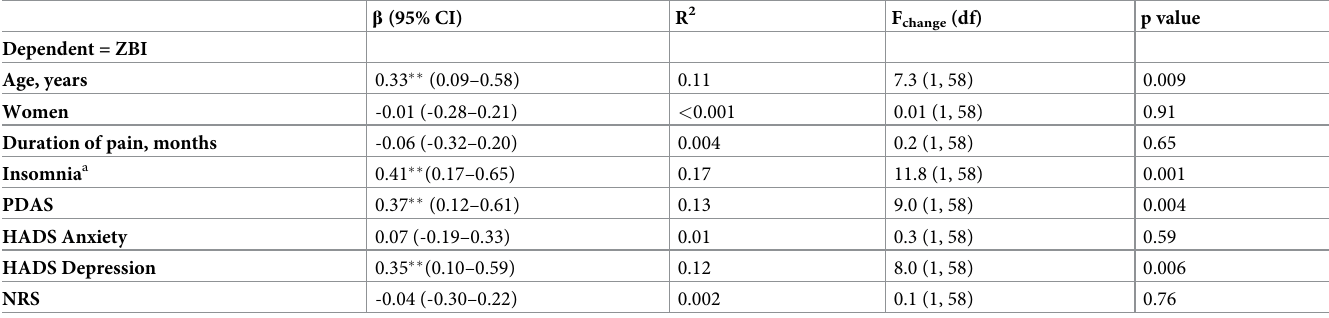
Table 2. Univariate regression analysis examining predictors of Zarit Burden Interview score. (n =